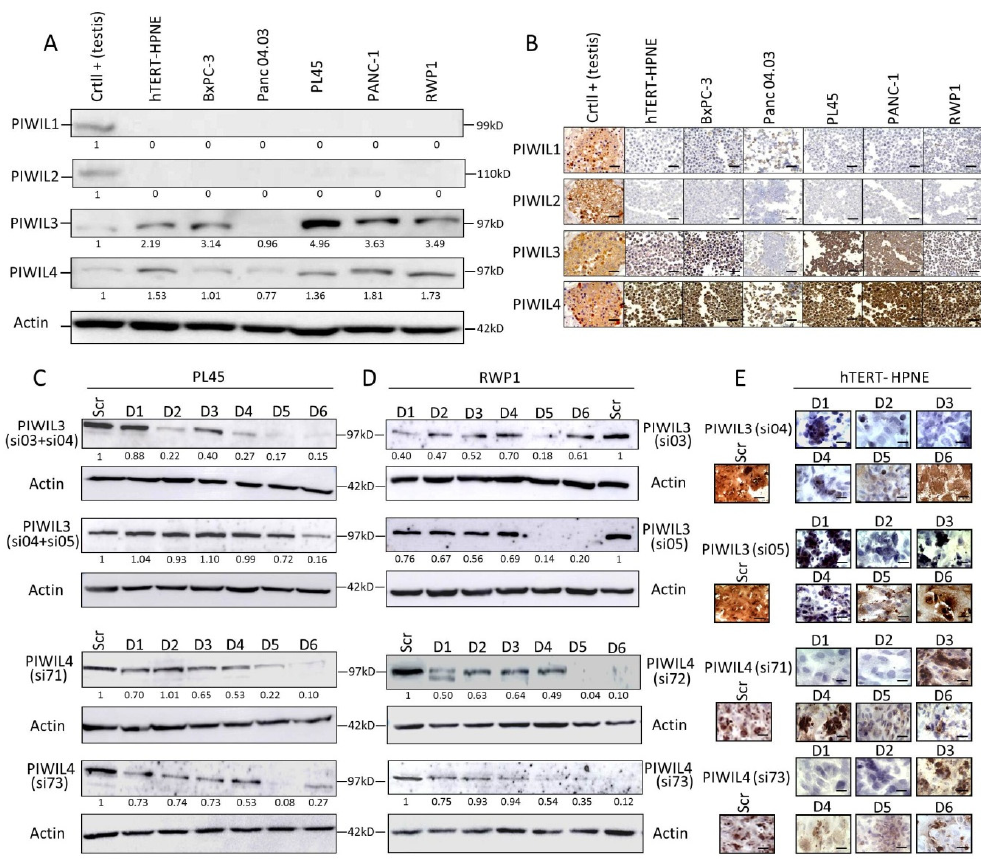
Figure 1. P-element-induced wimpy testis (PIWI) proteins present differential expression in pancreatic cancer (PC), and a late downregulation of PIWIL3 or PIWIL4 in tumor cell lines was found compared to non-tumor cell line. ( A ) Western blot analysis, and ( B ) representative micrographs of immunohistochemical staining of a panel of five human PC-derived cell lines and one non-tumor pancreatic cell line (hTERT-HPNE). A human testis tissue was used as positive control. Two independent downregulations of PIWIL3 (top) and PIWIL4 (bottom) were performed to carry out functional experiments with PL45 ( C ), RWP1 ( D ) and hTERT-HPNE ( E ). Crtl: control. kDa: kilodalton. Scr: Scramble. D1–6: Days 1–6. PIWIL3/Actin or PIWIL4/Actin ratio is represented under each protein band. Scale bar: 50 µm.